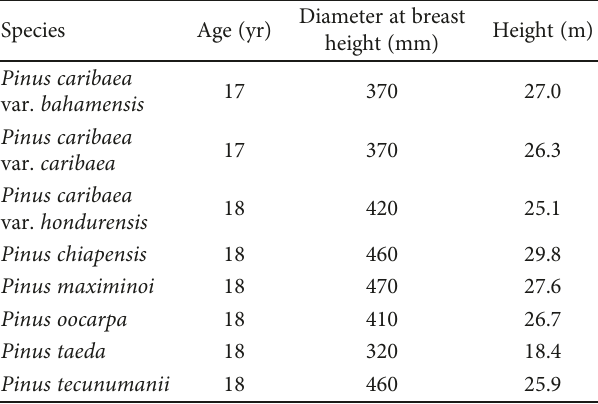
Table 3: Average diameter (at breast height) and height for the six species sampled. One species, Pinus caribaea , included three